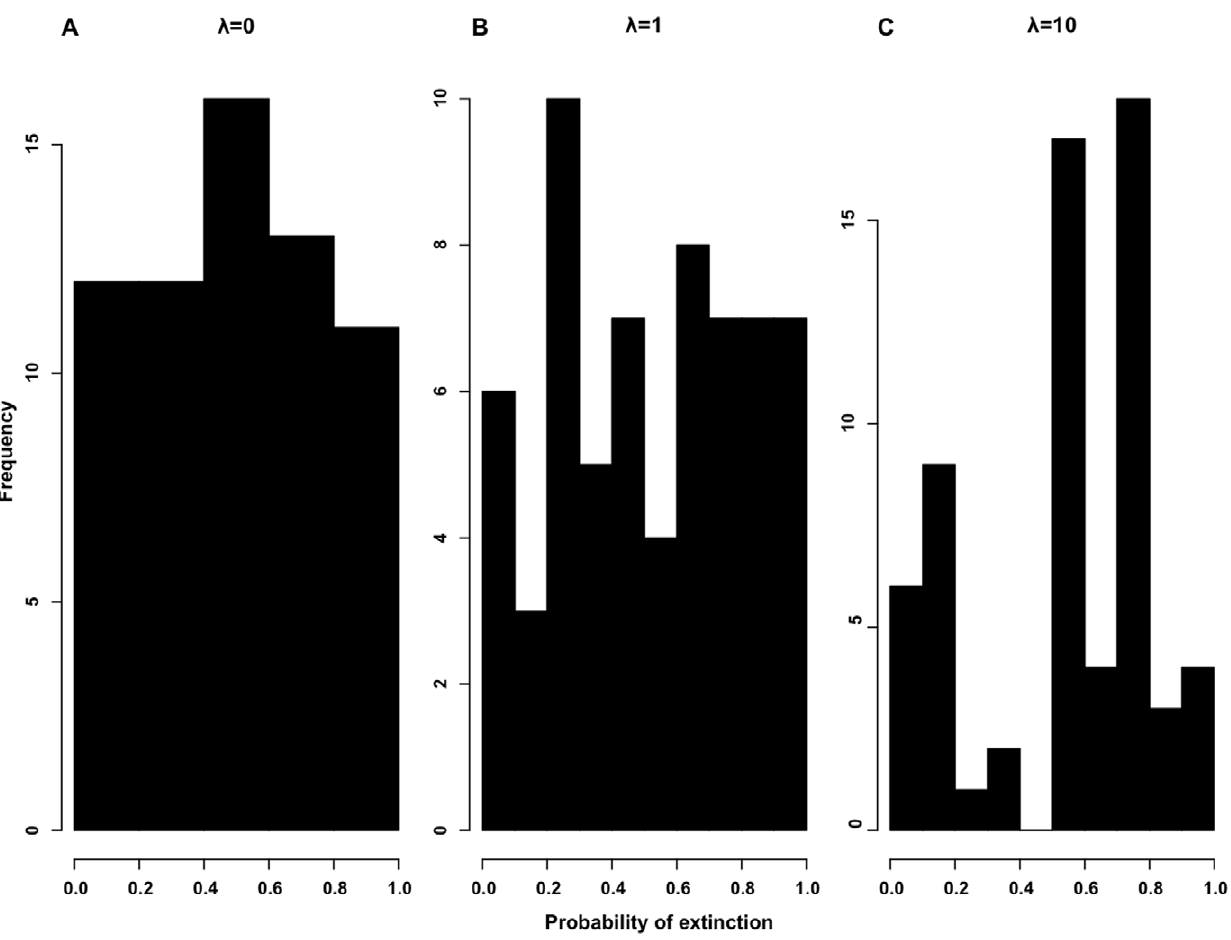
Figure 2. Differences in the extinction risk distributions. Extinction risk distributions across the tips of an example 64-tip Yule tree, modeled for three levels of phylogenetic clustering: l =0, 1, and 10. Each set has mean p(ext) =0.5.